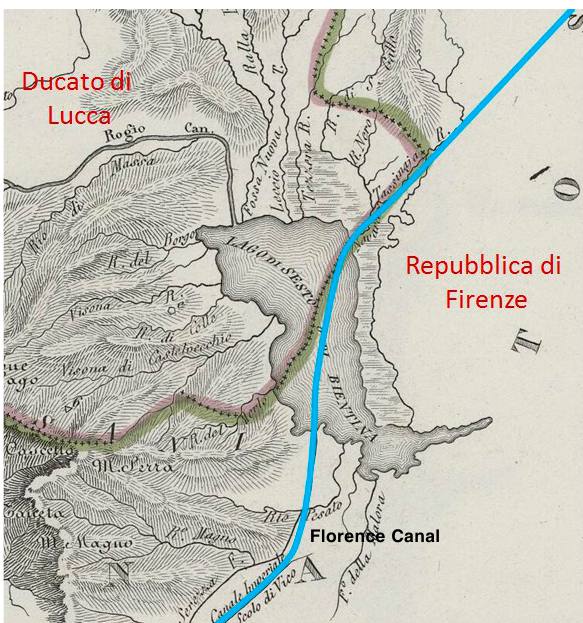
Figure 9. Lake of Sesto, or “of Bientina”, Carta orografica e idrografi- ca del Ducato di Lucca , in A. Zuccagni Orlandini, Atlante Geografico degli Stati Italiani , Firenze 1844, II.